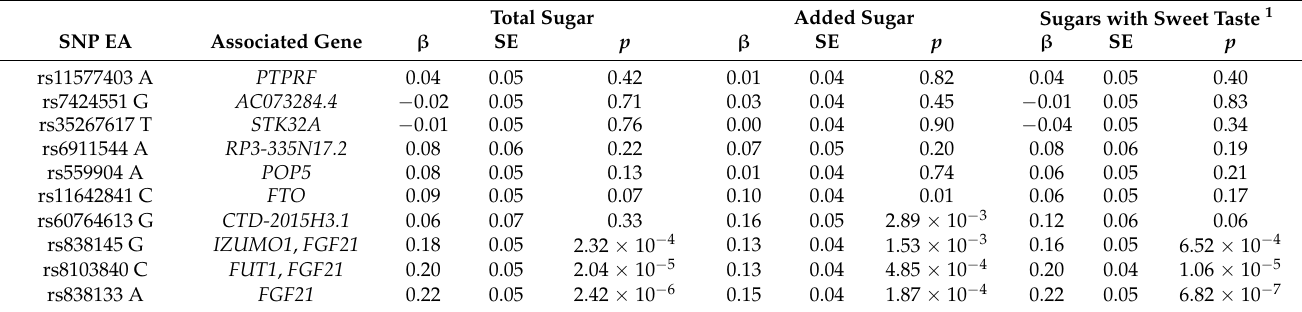
Table 3. Associations between the 10 primary SNPs and the main outcomes. Total Sugar Added Sugar Sugars with Sweet Taste 1 SNP